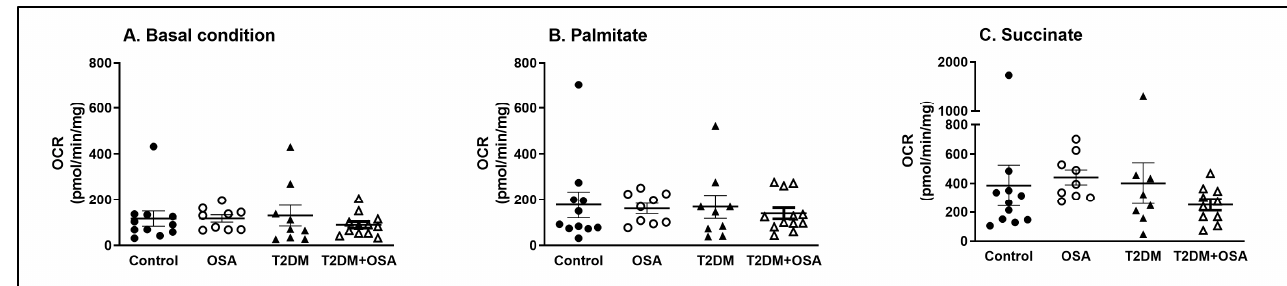
Figure 1. Oxygen consumption rate and substrate utilization in skeletal muscle biopsies. The oxygen consumption rate (OCR) in the muscle biopsies was measured using a respirometry chamber. Ini ‐ tially, the biopsy homogenate was supplemented with 1 mM malate + 1 mM ADP to evaluate the baseline OCR, defined mainly by the utilization of intracellular substrates ( A ). Subsequently, 0.04 mM palmitoyl carnitine was administered to assess lipid oxidation capacity ( B ), and 10 mM succin ‐ ate was added to provide an unlimited substrate for mitochondrial complex II, thus maximizing mitochondrial respiration ( C ). Control (nondiabetic persons without sleep apnea syndrome), OSA (nondiabetic persons with severe sleep apnea syndrome), T2DM (type 2 diabetes mellitus patients without severe sleep apnea syndrome), and T2DM + OSA (type 2 diabetes mellitus patients with severe sleep apnea syndrome). Data are presented as individual values and error bars displaying the mean ± SEM; an ANOVA test was performed to assess differences between the groups.